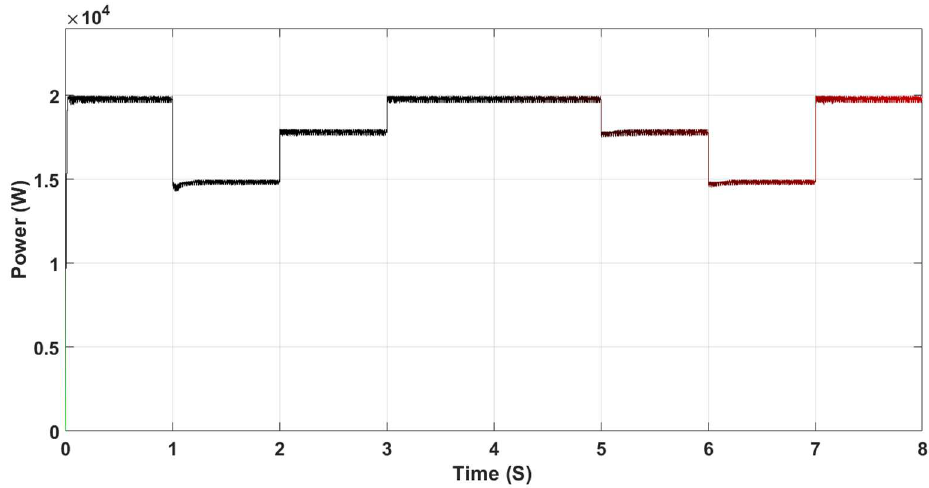
Figure 19. PV output power.